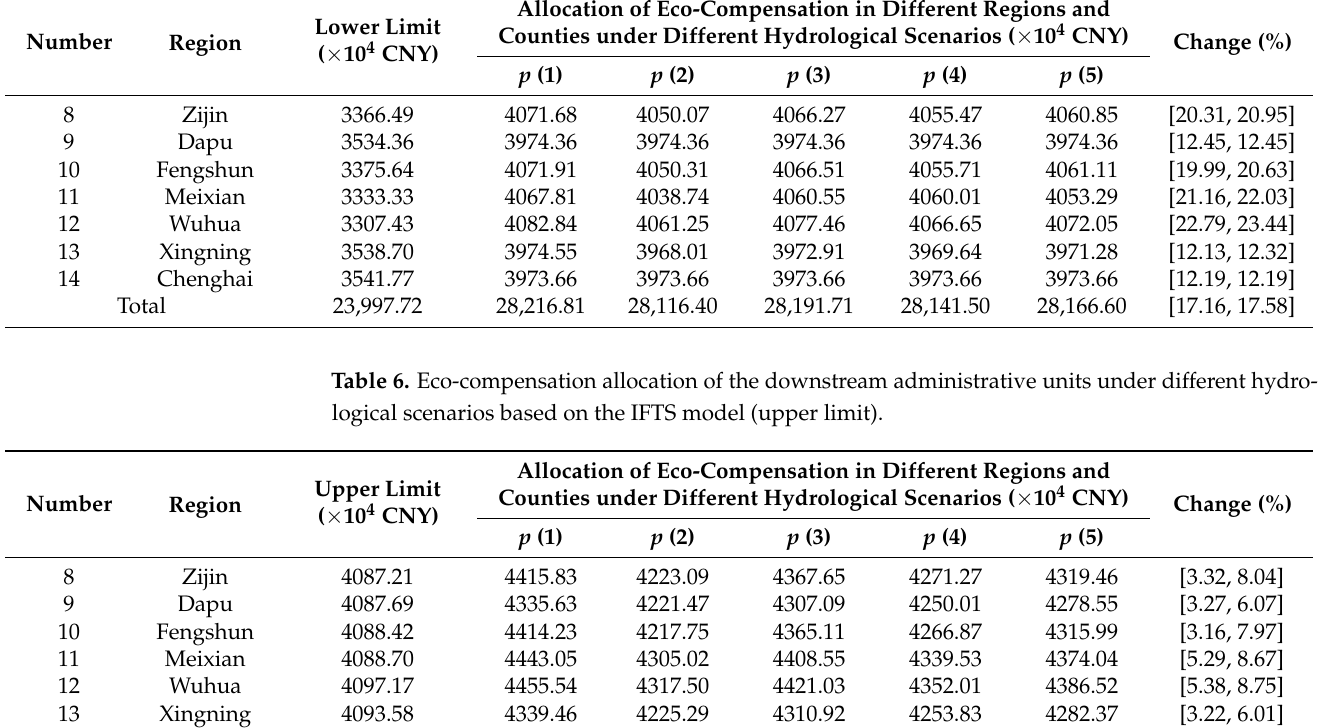
Table 5. Eco-compensation allocation of the downstream administrative units under different hydro- logical scenarios based on the IFTS model (lower limit).